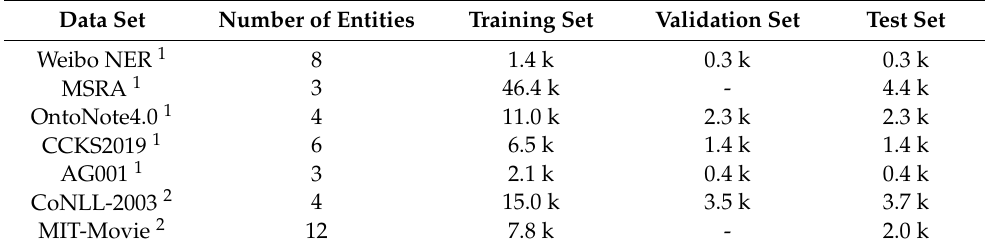
Table 1. Dataset